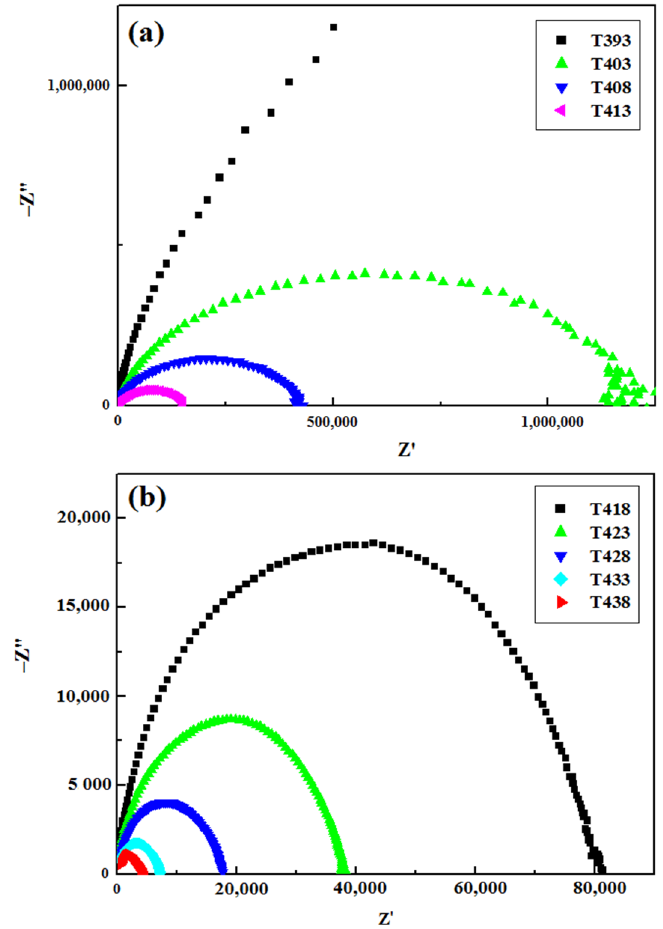
Figure 10. − Z ″ versus Z’: ( a ) in the range 393-413 K and ( b ) in the range 418-438. Figure 10. − Z” versus Z’: ( a ) in the range 393–413 K and ( b ) in the range 418–438.